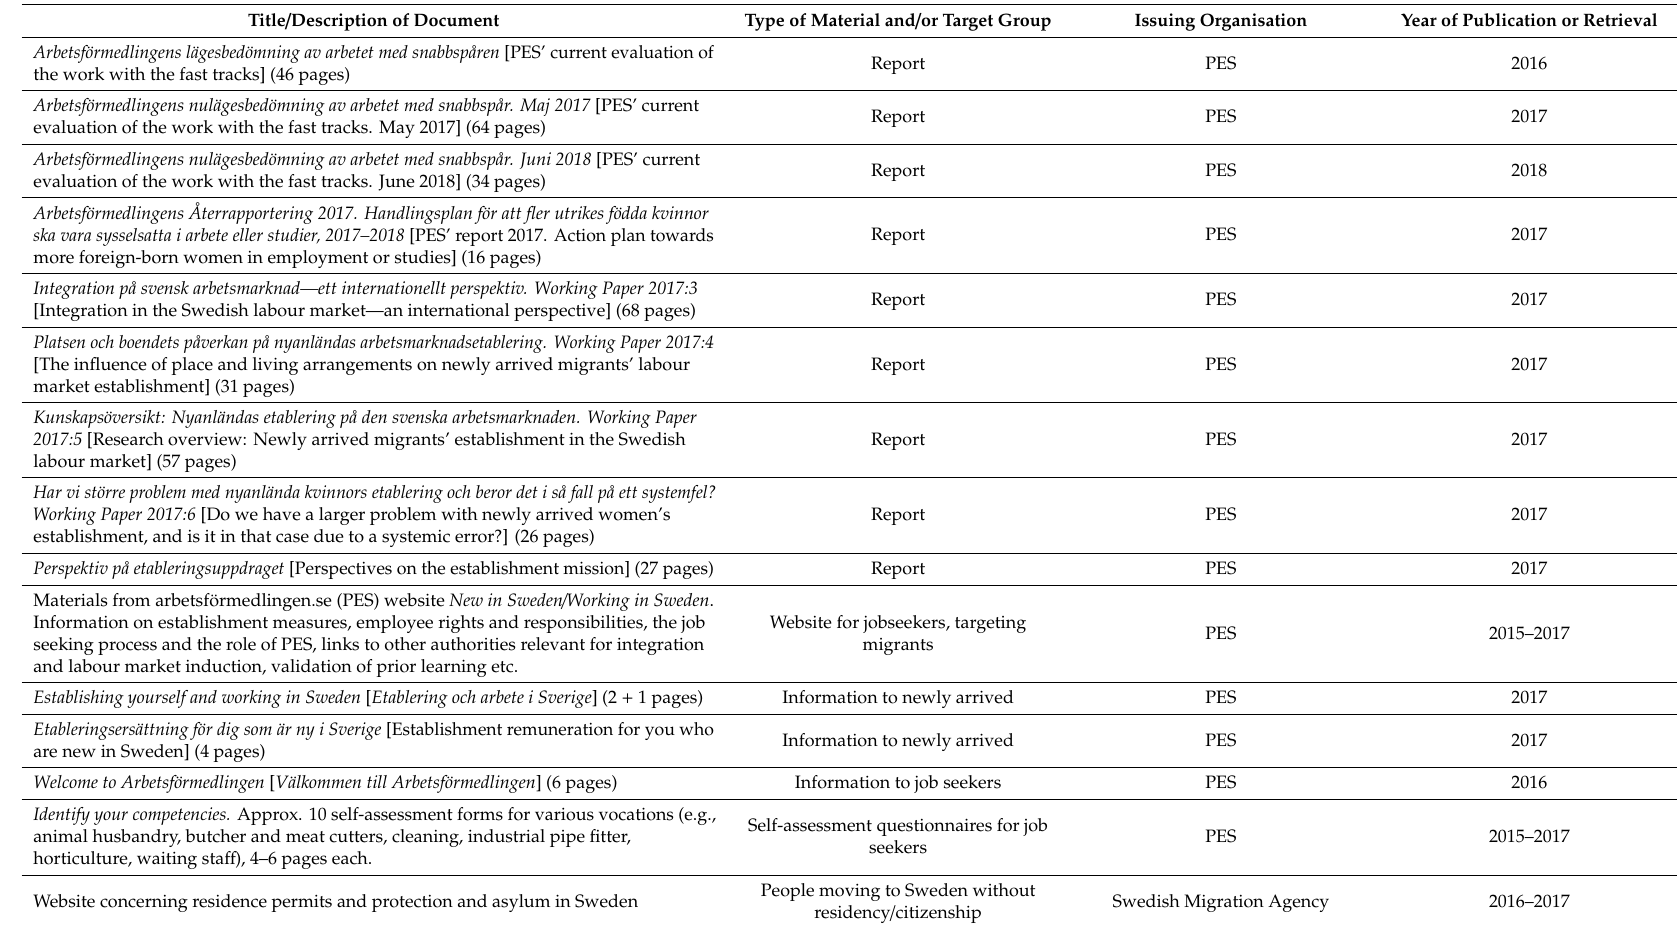
Table 1. Summary of